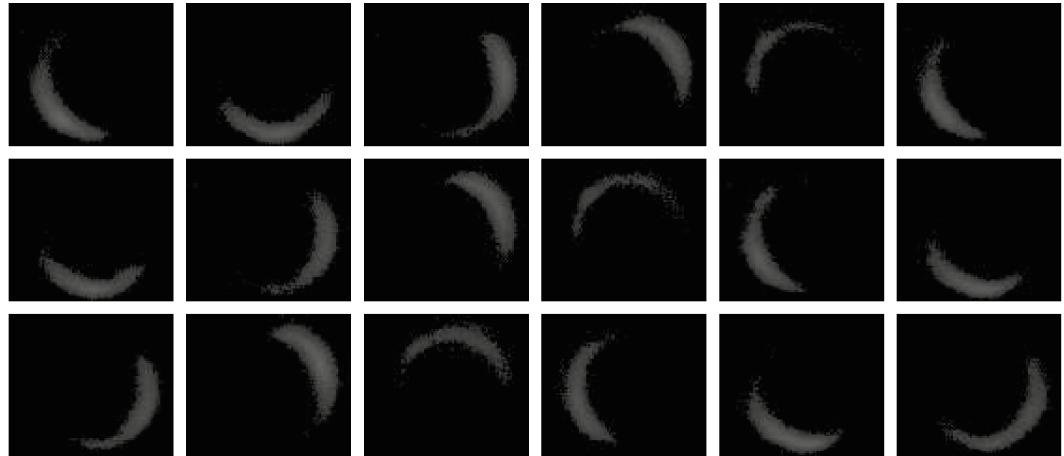
Figure 9: Continuous high-speed images for RDW rotating counterclockwise, 20000 fps and air fl ow 708g/s.